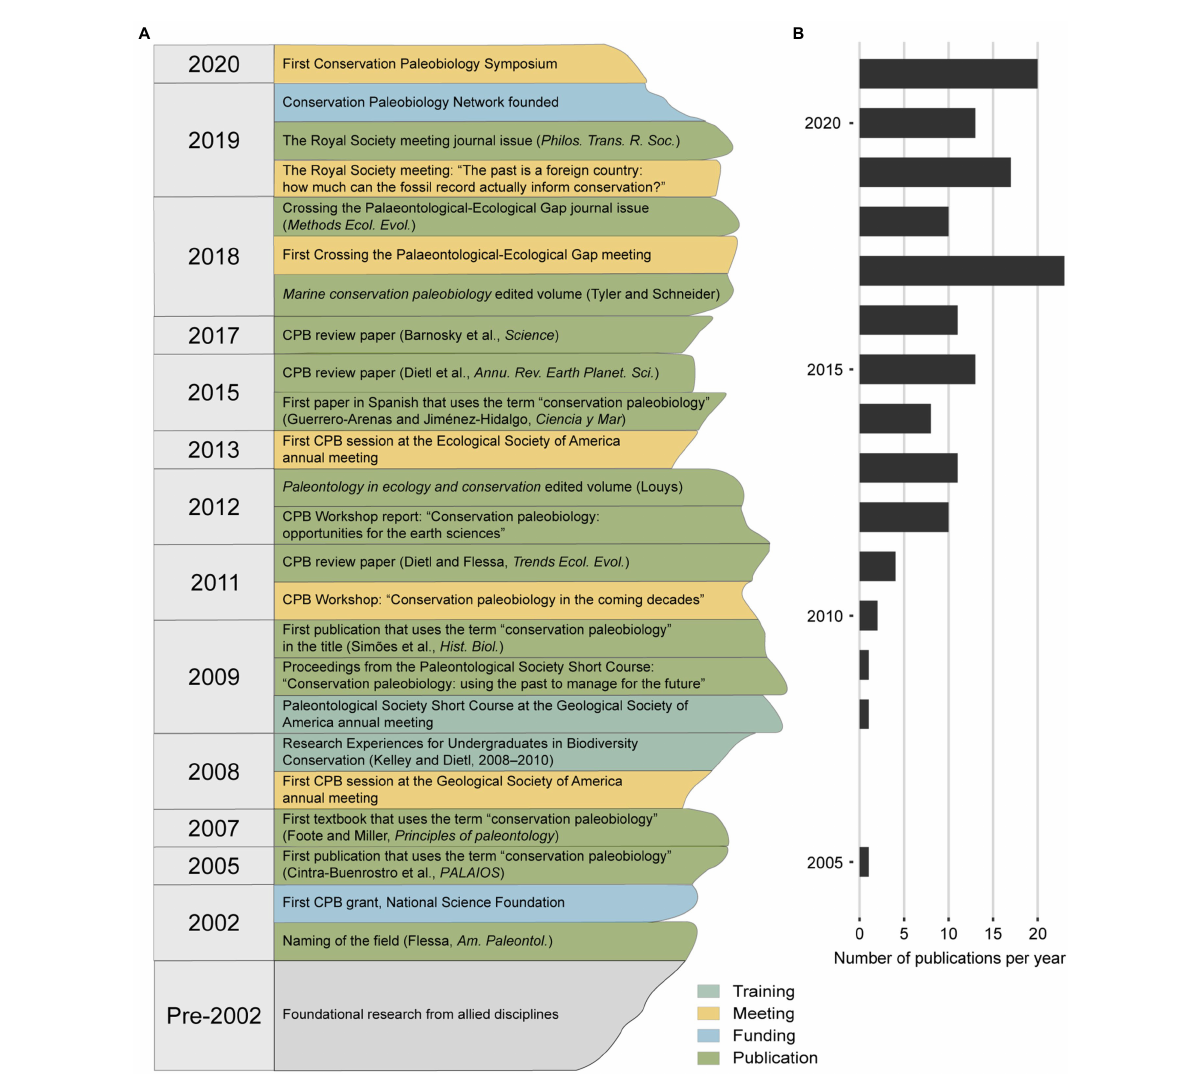
FIGURE 1 (A) Timeline of key events in CPB’s development following its coining in 2002, alongside (B) the number of publications in the literature review that used the term “conservation paleobiology” per year from 2002 to 2021 (Flessa, 2002; Cintra-Buenrostro, 2005; Foote and Miller, 2007; Simões, 2009; Dietl and Flessa, 2011; Louys, 2012; Dietl et al., 2015; Guerrero-Arenas and Jiménez-Hidalgo, 2015; Barnosky et al., 2017; Tyler and Schneider,